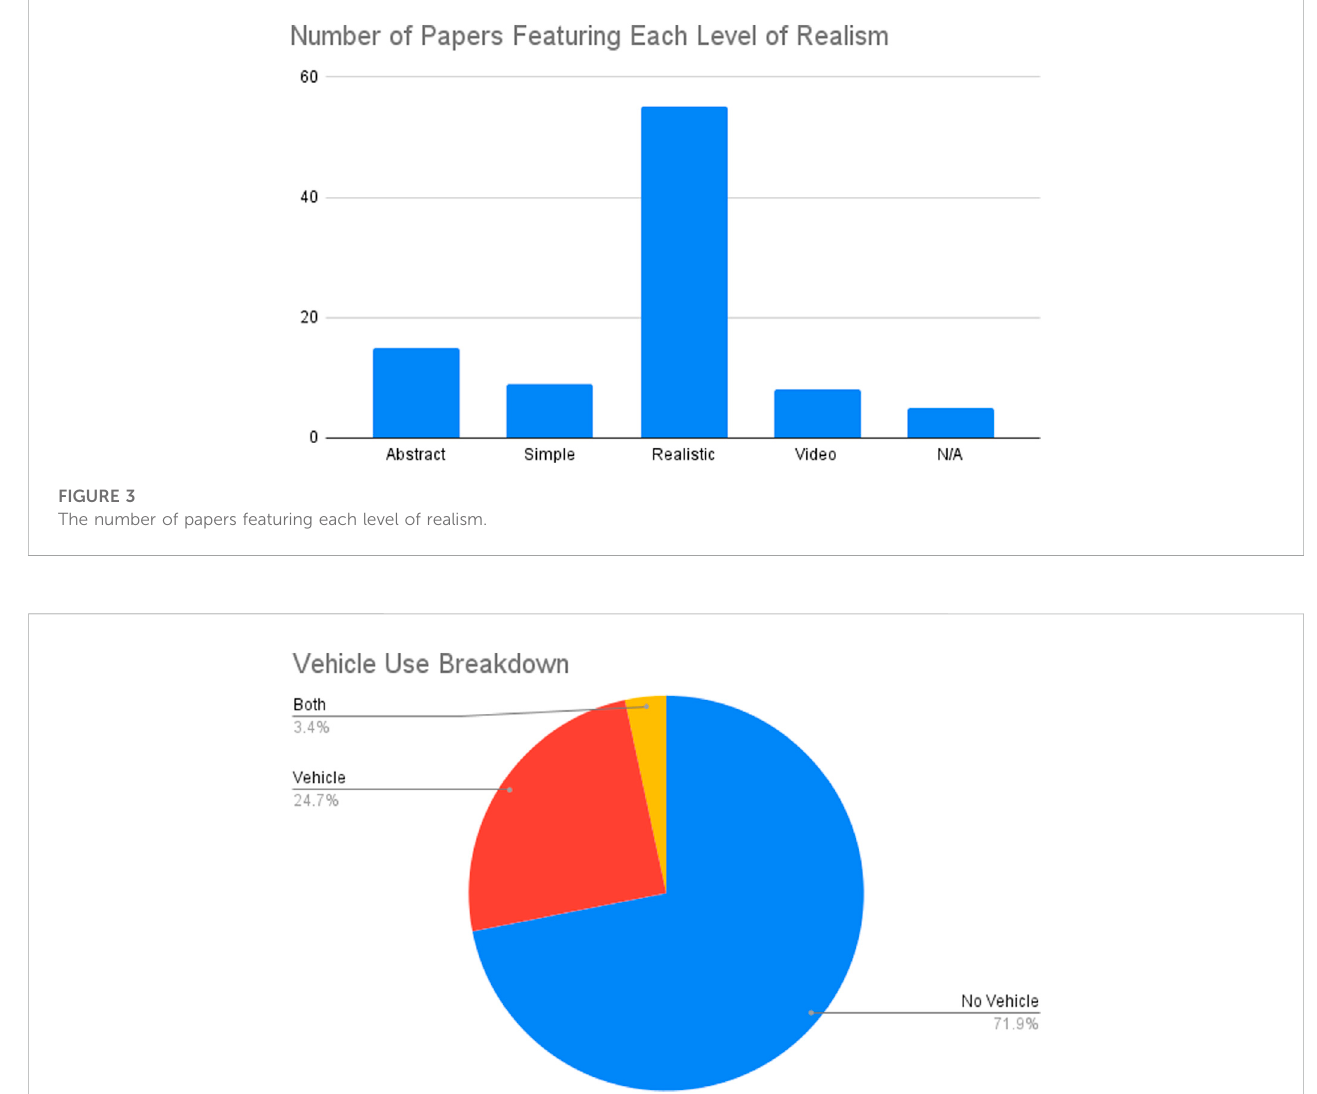
The portion of papers using vehicles, using none, or using both.